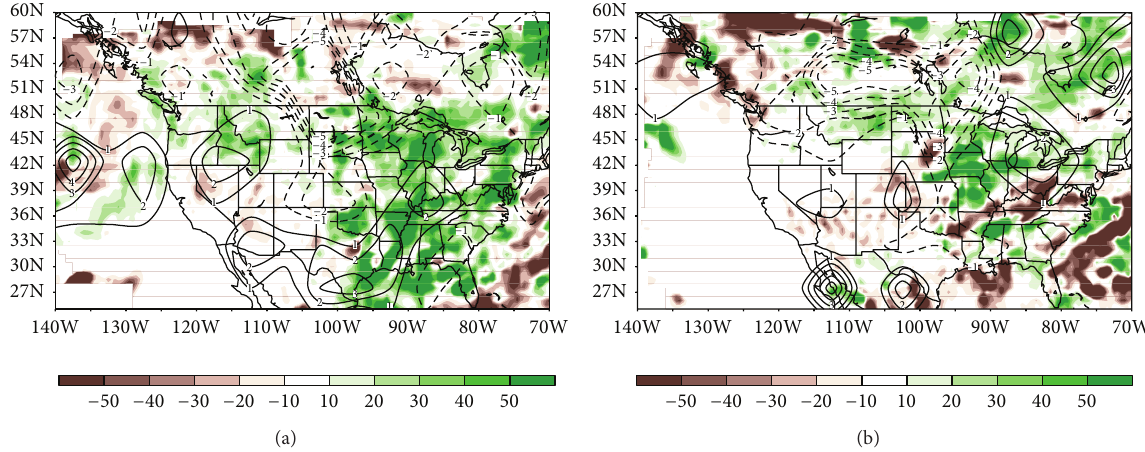
Figure 4: Cyclone frequency difference between 1993 and 1988 (contour) and cyclone-induced precipitation difference for 1993 minus 1988 (shaded in mm) for (a) AMJ and (b) JAS. Data from CFSR.